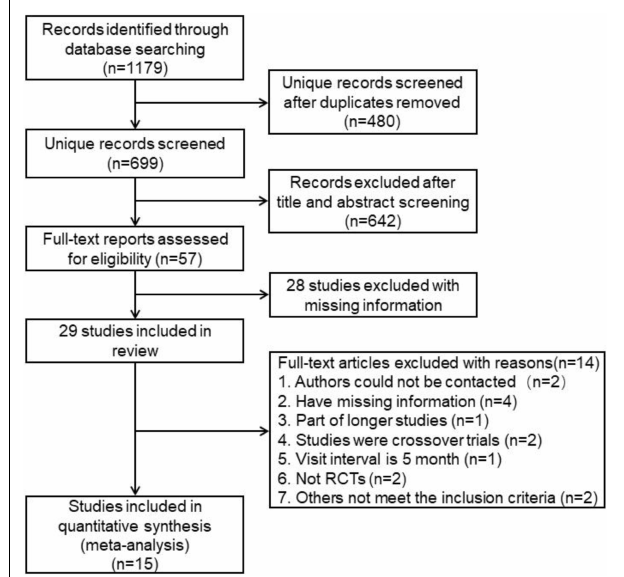
FIGURE 1 | A flowchart of study